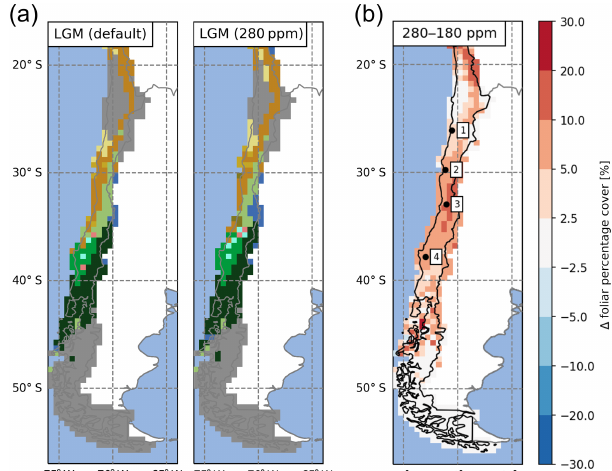
Figure 10. (a) Effect of atmospheric CO 2 , represented as [CO 2 ], concentrations on the simulated distribution of biomes for the Last Glacial Maximum (LGM) time-slice simulations (left panel: default LGM setup of this study with [CO 2 ] = 180ppm; right panel: con- trol run with preindustrial [CO 2 ] = 280ppm). (b) Difference plot of resulting foliar projected cover (280–180ppm). The number 1 represents Pan de Azúcar, 2 represents Sta. Gracia, 3 represents La Campana, and 4 represents